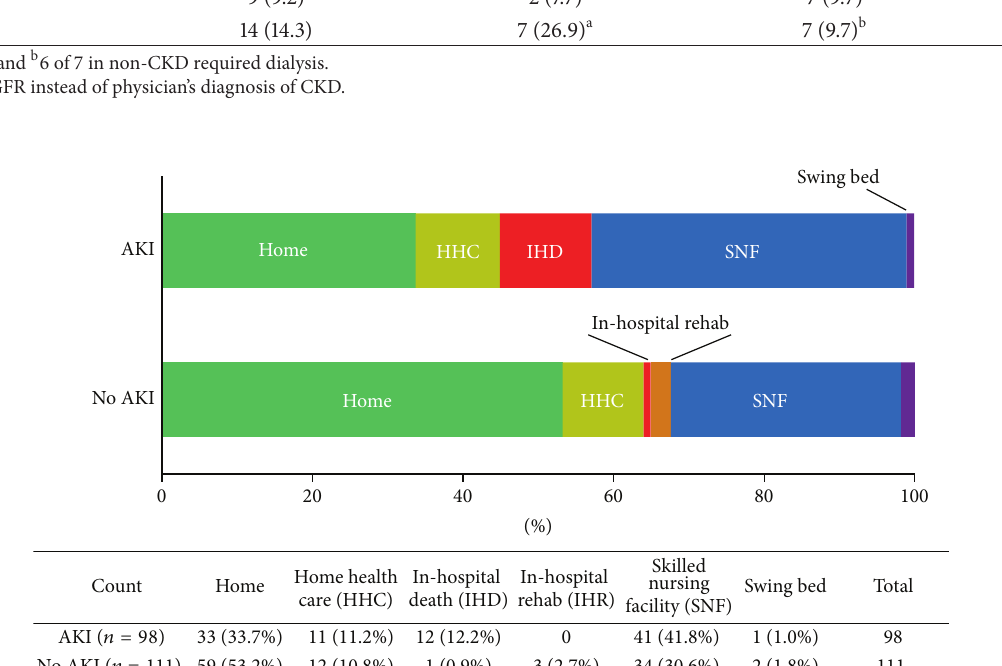
versus 9.2 ± 4.2 days for non-AKI patients, 𝑝 < 0.0001 . Patient disposition was different in octogenarians with and without AKI (Figure 1, 𝑝 = 0.001 ). More AKI patients